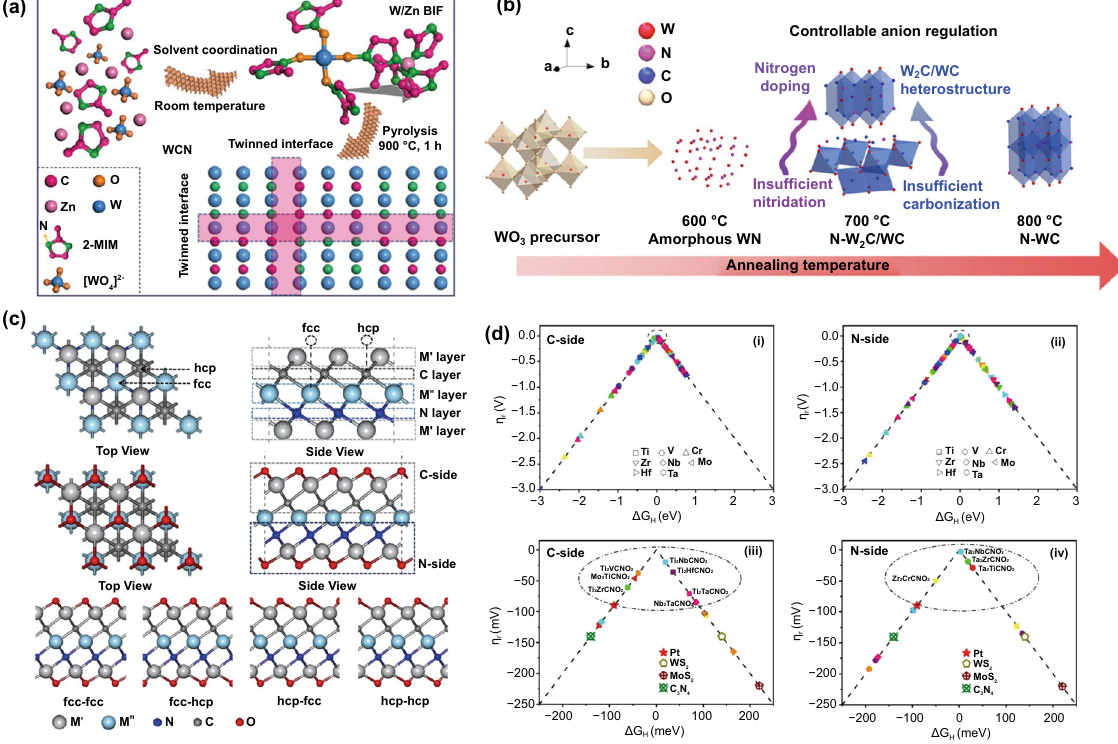
Fig. 4 a Schematic diagram of the construction method for twinned WCN. Reprinted with permission from Ref. [92]. Copyright Year 2019, Wiley–VCH Verlag GmbH & Co. KGaA, Weinheim. b Schematic representation of the controllable anion regulation. Reprinted with permis- sion from Ref. [93]. Copyright Year 2020, American Chemical Society. c The bare structure of ordered double transition metal carbonitrides, d The volcano plotted for all 64 M ′ 2 M ″ CNO 2 -MXenes. (i) C-side of M ′ 2 M ″ CNO 2 -MXenes. (ii) N-side of M ′ 2 M ″ CNO 2 -MXenes. (iii) The cor- responding enlarged view of the area near the volcano apex of C-side. (iv) The corresponding enlarged view of the area near the volcano apex of N-side. The different shapes represent different M ′ , and different colors represent different M ″ (red, orange, yellow, green, cyan, blue, purple, and pink represent Ti, V, Cr, Zr, Nb, Mo, Hf, and Ta, respectively). Reprinted with permission from Ref. [94]. Copyright Year 2021, Springer